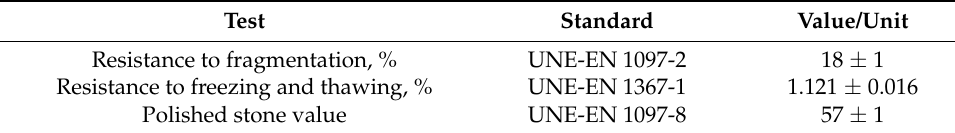
Table 7. Mechanical properties of the leaching